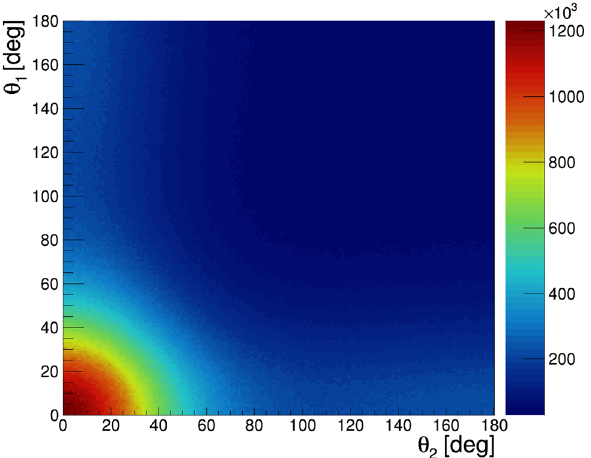
Fig. 11 Event distribution as a function of Compton scatterings angles θ θ 1 and 2 simulated for the case of an ideal detector with 100% regis- tration efficiency. The figure is based on 5 . 96 × 10 9 simulated events